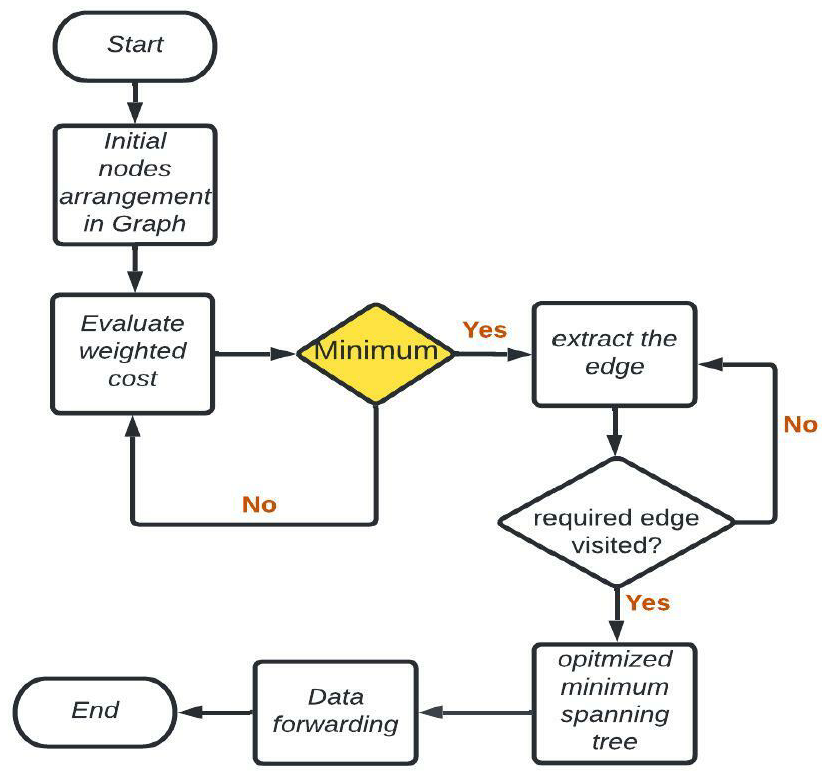
Figure 2. Flowchart of the proposed system for optimized subgraphs using graph theory.